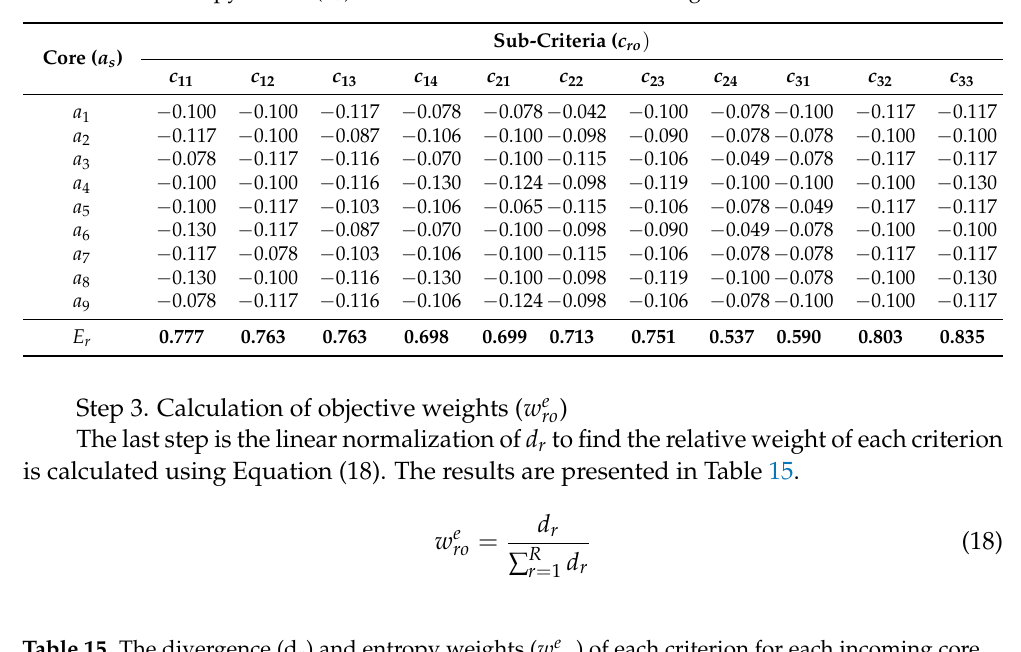
Table 15. The divergence (d r ) and entropy weights ( w e ro ) of each criterion for each incoming core.